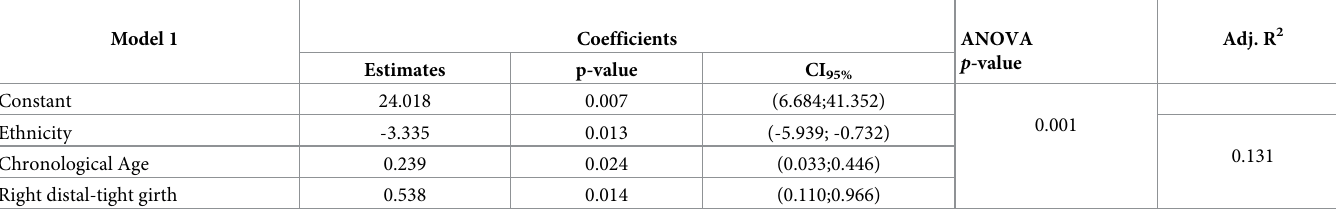
Table 4. Multiple linear regression model for right grip strength in elite male rink hockey athletes.